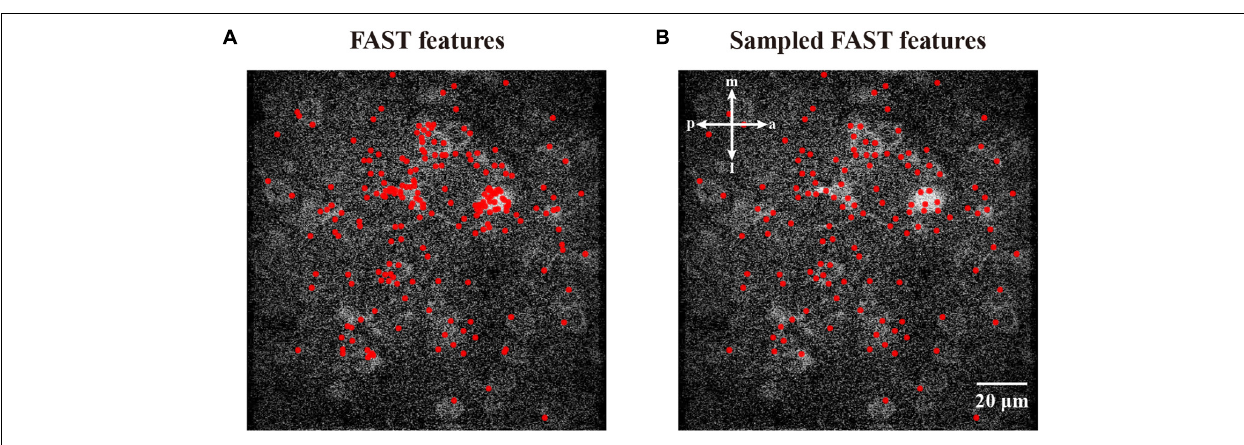
FIGURE 2 | Features from accelerated segment test feature detection and sampled FAST features. (A) The corner features detected by FAST algorithm. (B) The sampled FAST features are uniformly distributed for reducing the computational cost. The features are represented as red